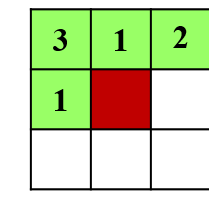
Figure 7. Example of point labeling. The preceding neighbor has the minimum label of